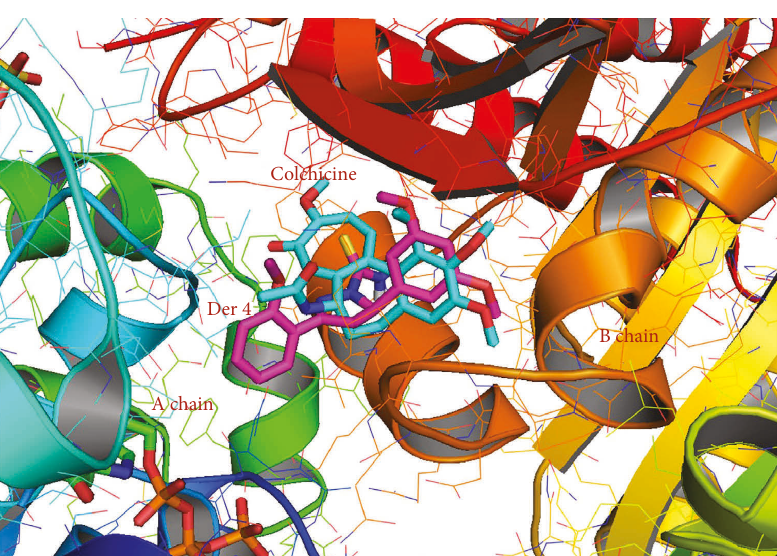
Figure 7: The 3D images of colchicine (cyan) and derivative 4 (magenta) contained in the binding pocket of 6xer.pdb generated using PyMol (the PyMOL Molecular Graphics System, Schr¨odinger,